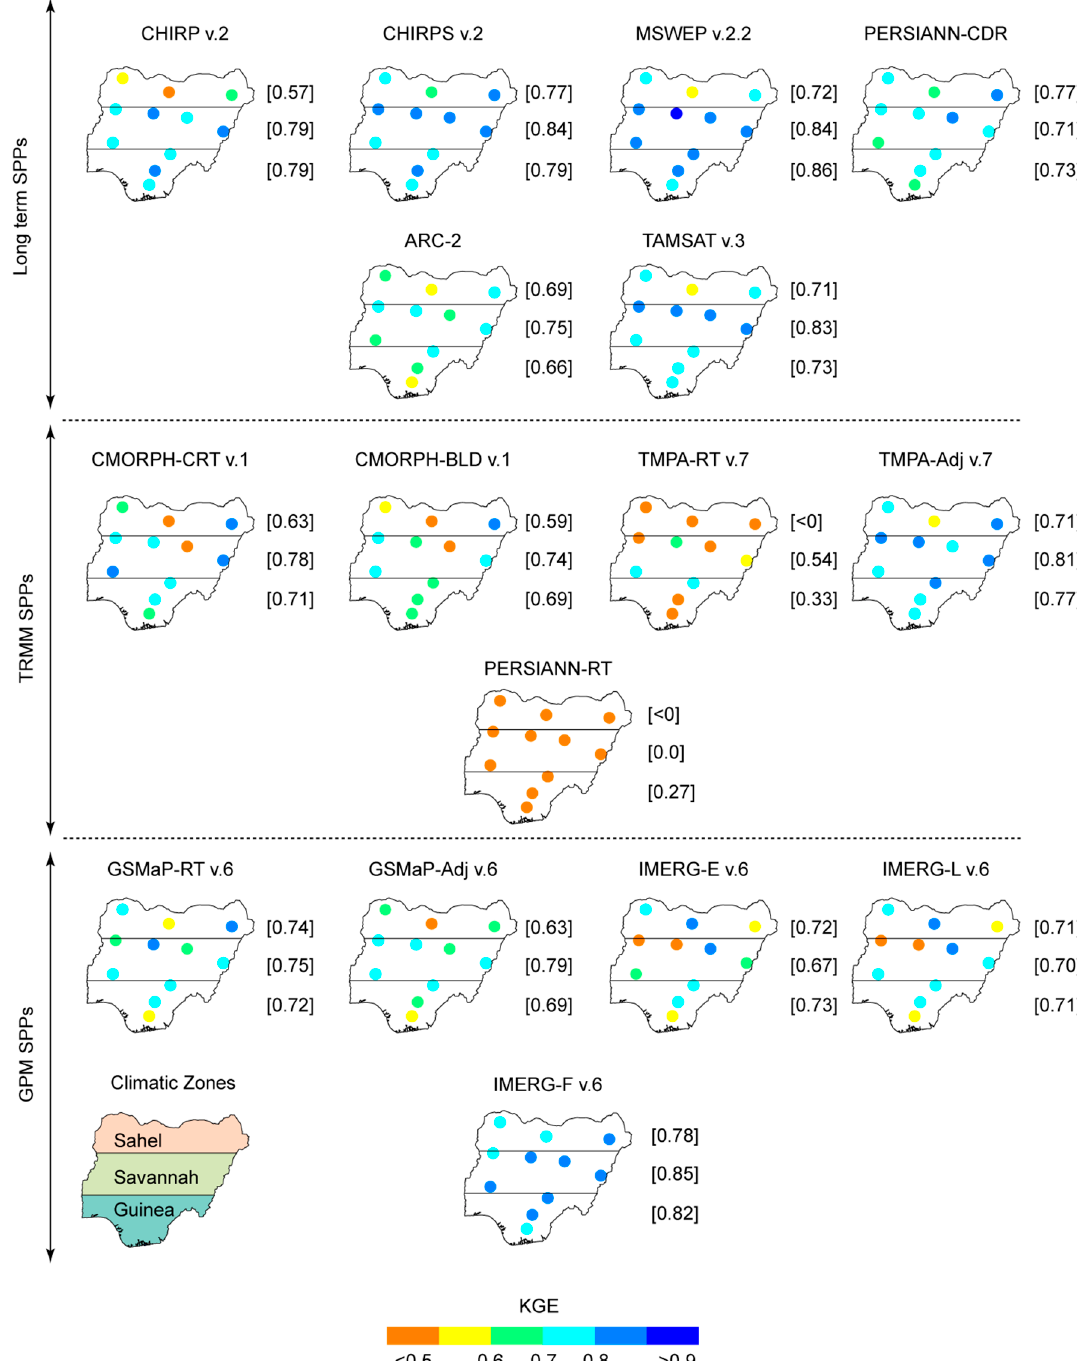
Figure 4. KGE values obtained at the grid cell level of all the SPPs corresponding to gauge stations in the period 2000–2012. The SPPs are grouped according to their respective categories, and the gauges are separated by the country’s ecological zones .